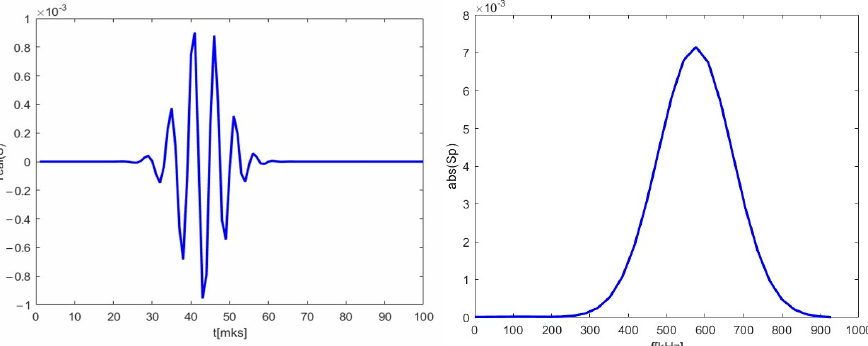
Figure 13. ( left ) DBS signal for the 48 GHz probing frequency; ( right ) calculated spectrum of the signal on the left.